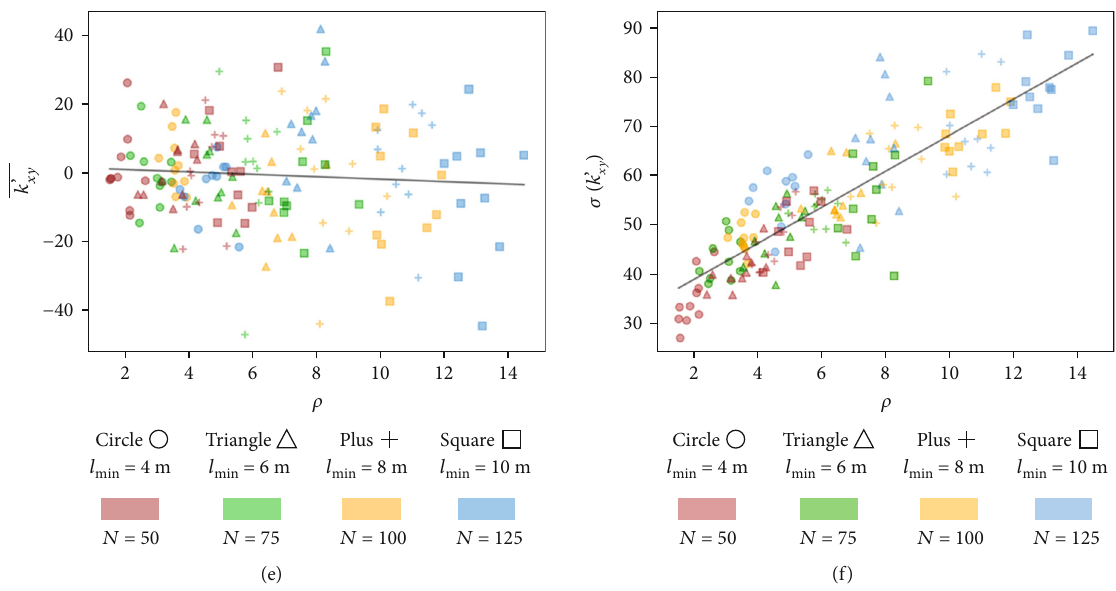
Figure 5: Plots of the mean and standard deviation of the dimensionless equivalent permeability tensor components with the dimensionless fracture density ρ for varied fracture geometric